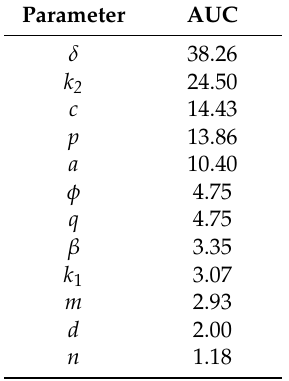
Table 2. AUC of virus equation for each parameter in Saenz